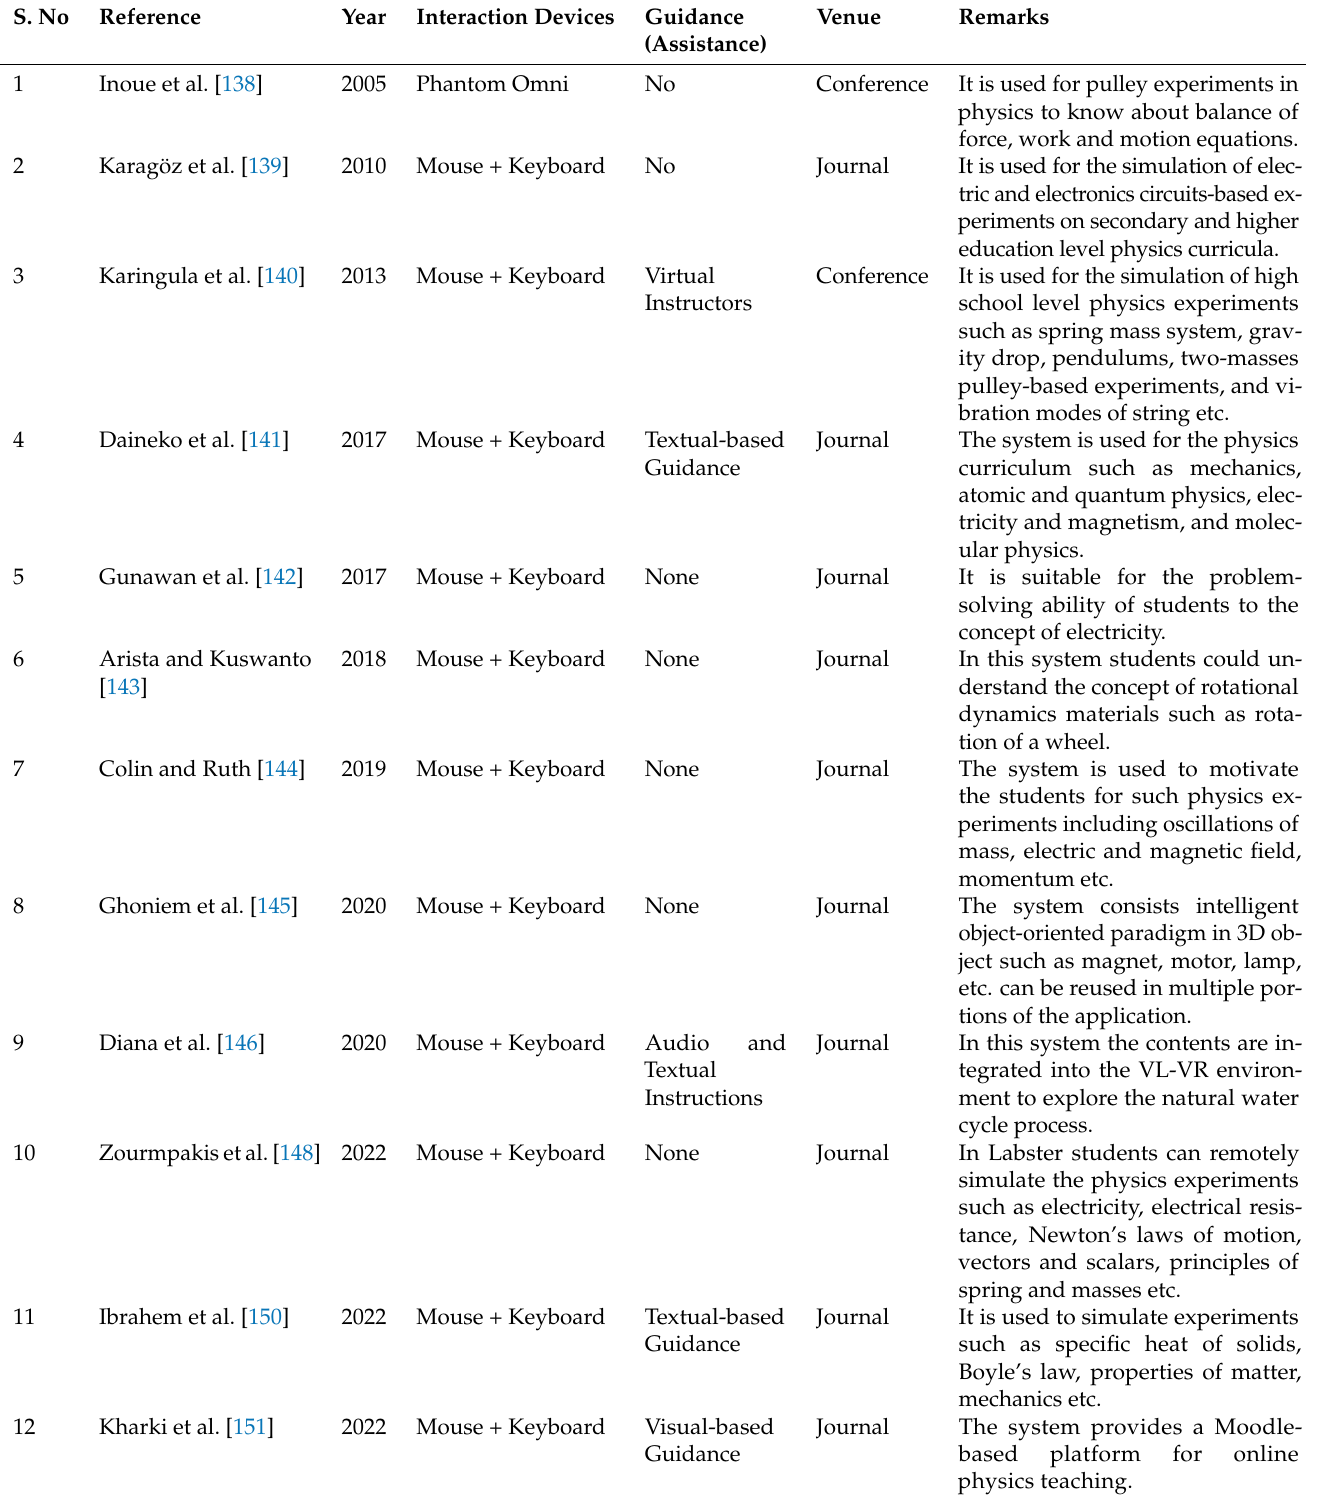
Table 6. Analysis of the existing interactive physics laboratories in